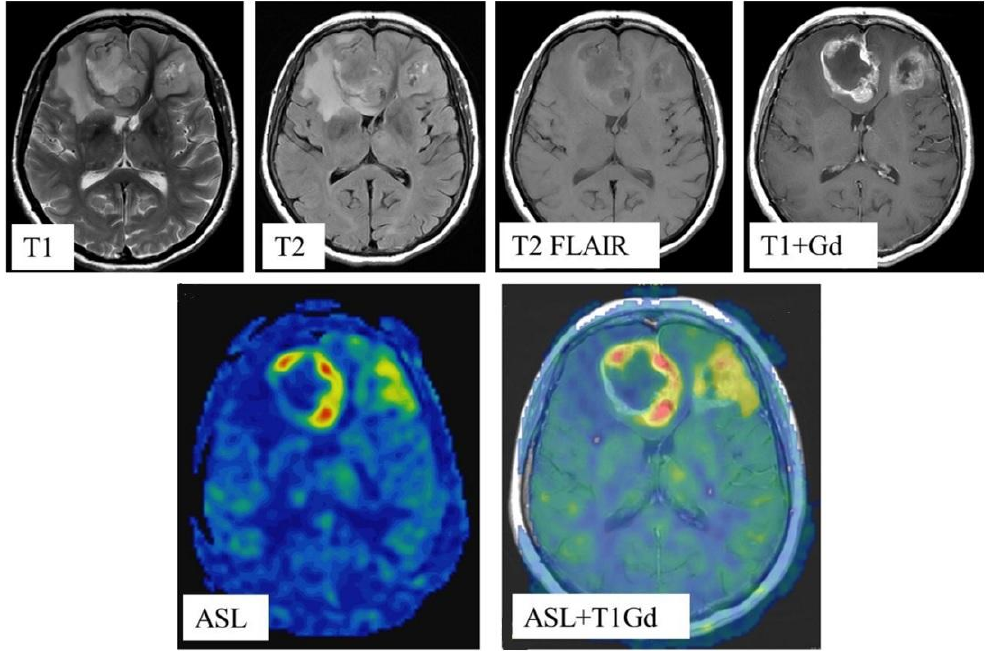
Figure 2. MRI scans and quantitative CBF maps of anterofrontal region IDH1-wildtype glioblastoma. ASL perfusion showed high TBF values (247.2 mL/100